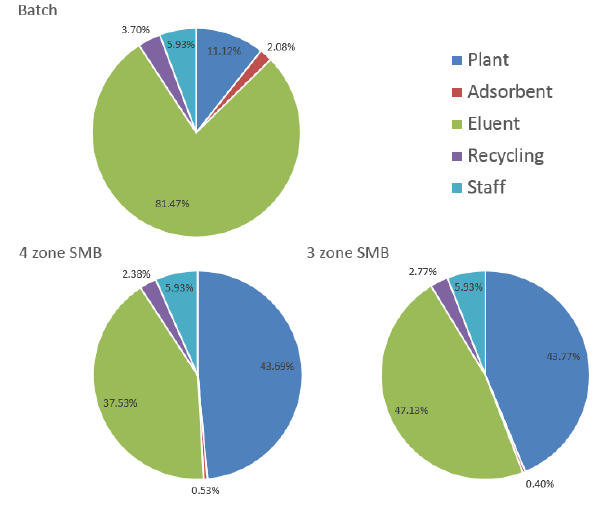
Figure 16. Break down of costs for the batch and the two SMB processes.